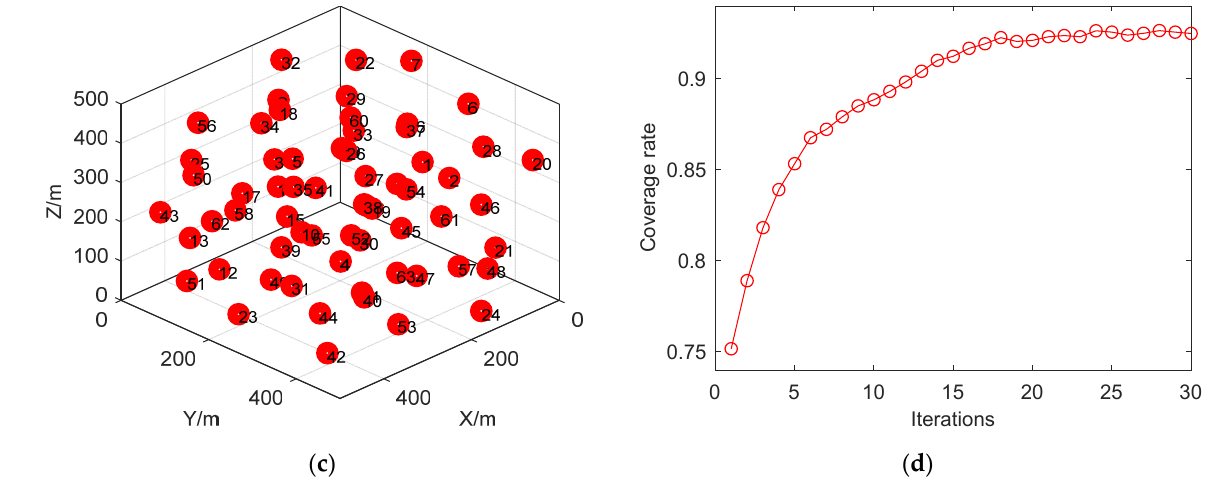
Figure 7. Random 3D space node movement process. ( a ) Node initial deployment. ( b ) Node movement track. ( c ) Optimized node deployment. ( d ) Coverage curve.